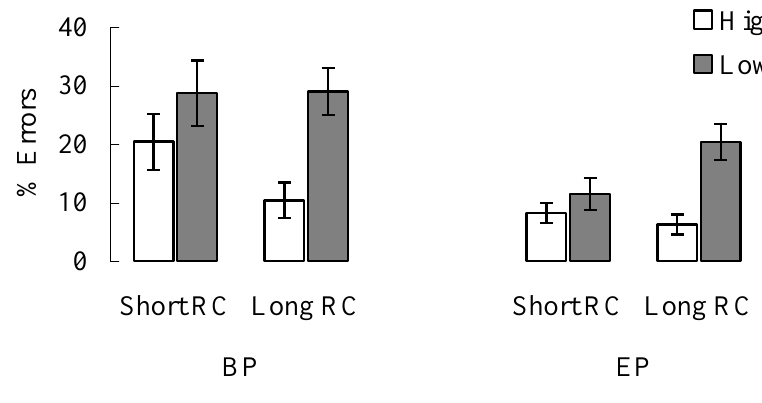
Figure 1. Mean percent errors in Frame 3 for BP and EP participants responding to comprehension questions about materials forced to attach high or low, with short or long